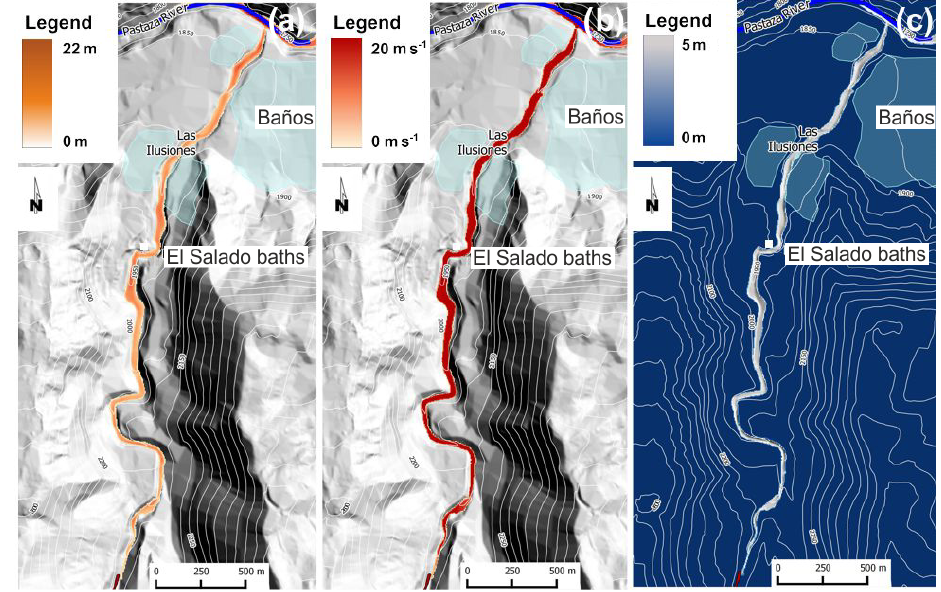
Figure 6. The 2008 simulated event. (a) Maximum thickness, (b) maximum velocity, and (c) erosion depth.